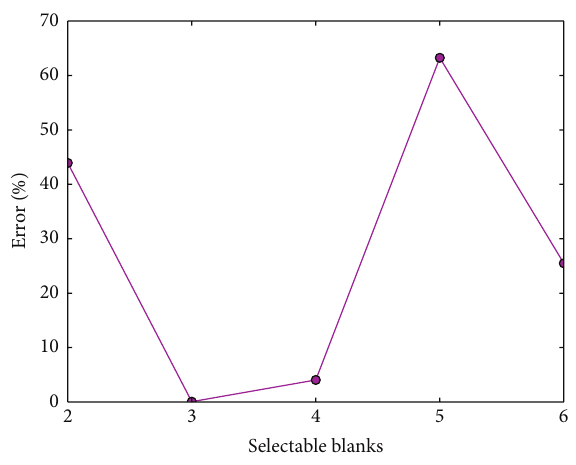
Figure 10: Percentage error from optimal values for NOMAD.